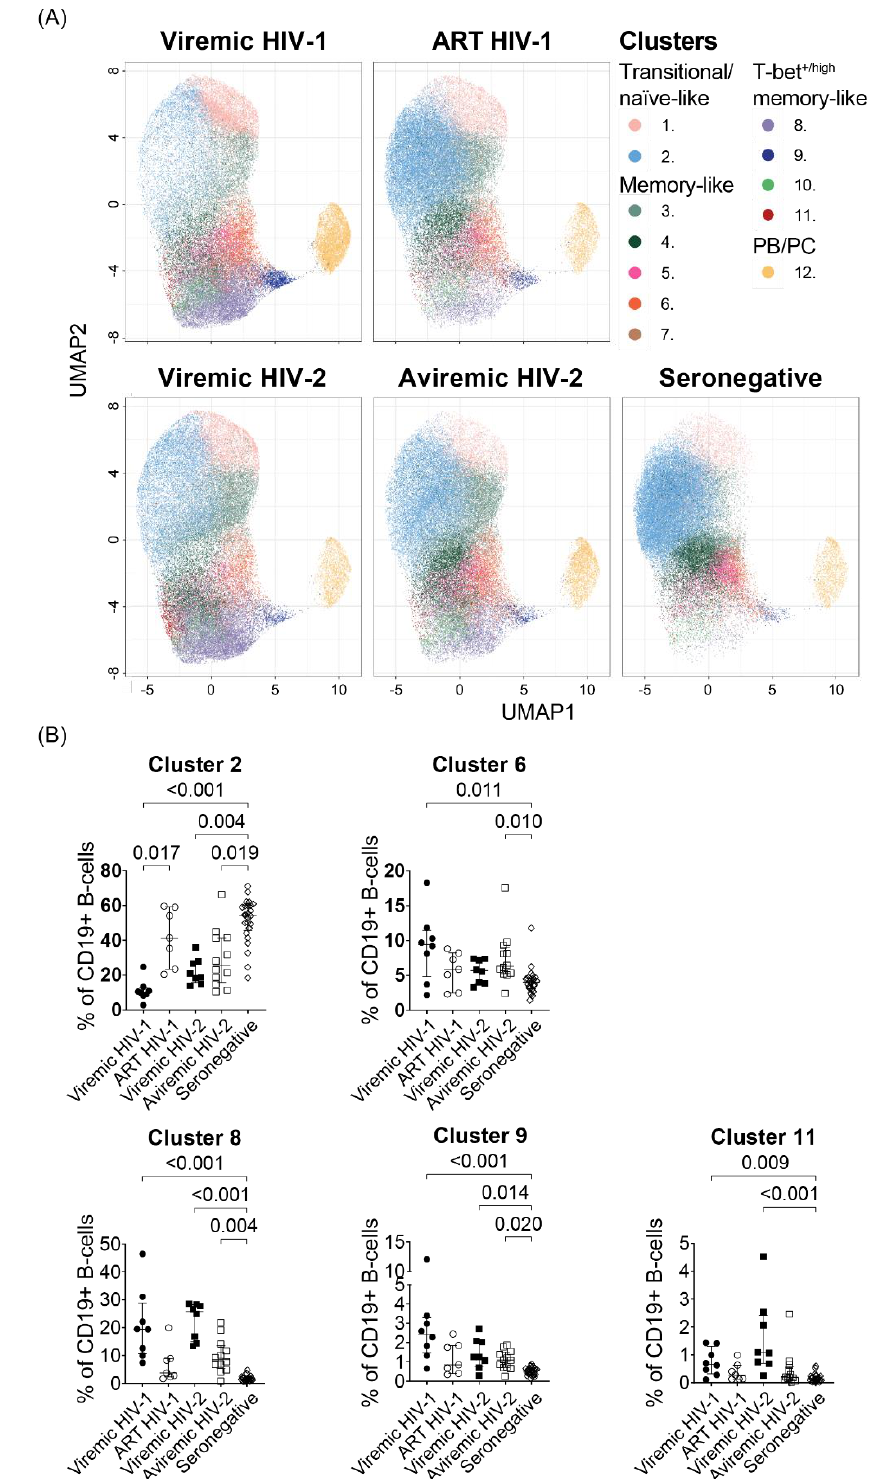
Figure 3. Specific B-cell perturbations within HIV-1- and HIV-2-infected individuals were identified by consensus hierarchical clustering. ( A ) FlowSOM clusters projected on UMAP plots faceted by HIV status group. ( B ) FlowSOM cluster frequency in treatment-naïve or sub-optimally ART-treated HIV-1 (viremic HIV-1, n = 8), successfully ART-treated HIV-1 (ART HIV-1, n = 7), viremic HIV-2 (viremic HIV-2, n = 8), treatment-naïve aviremic HIV-2 (aviremic HIV-2, n = 12)-infected individuals and HIV seronegative (seronegative, n = 25) individuals. Nonparametric Kruskal–Wallis test followed by Dunn’s post hoc was performed to compare groups. Medians and IQR are depicted in scatter plots.